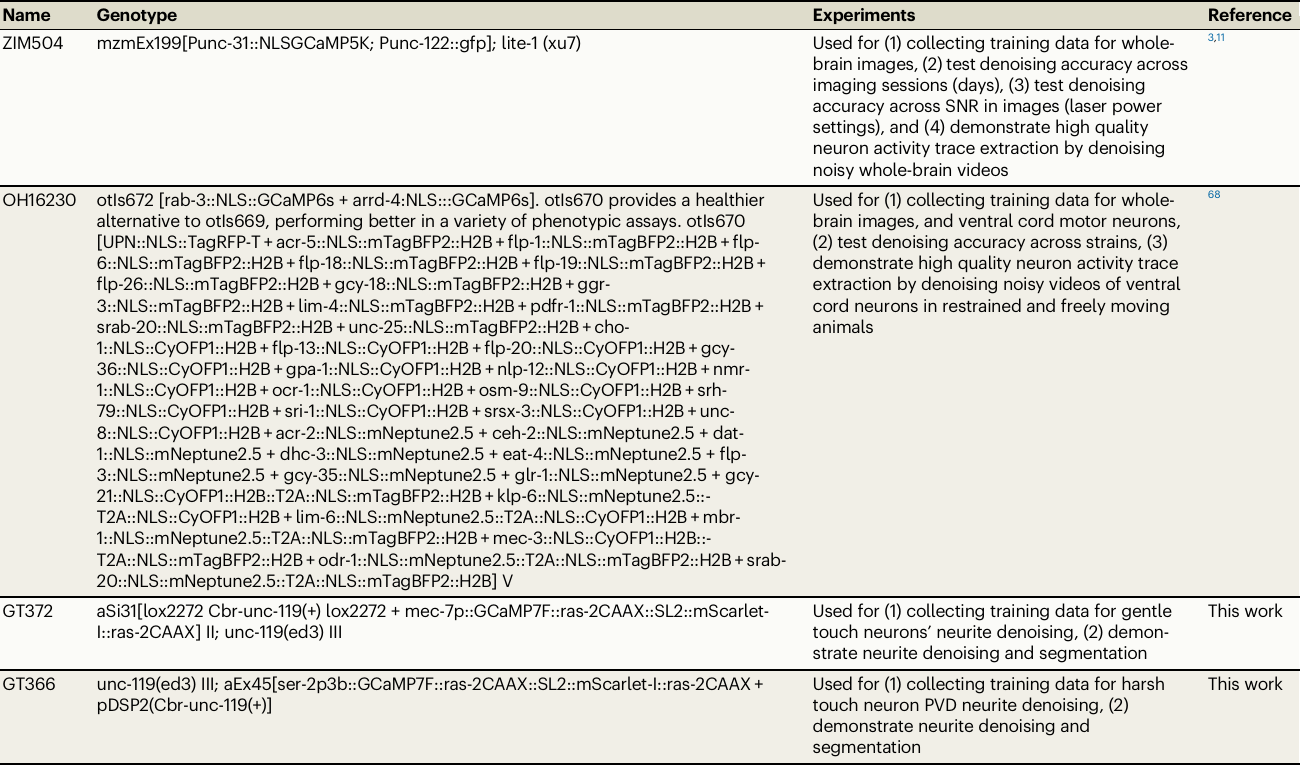
Table 1 | List of strains used in this work Name Genotype